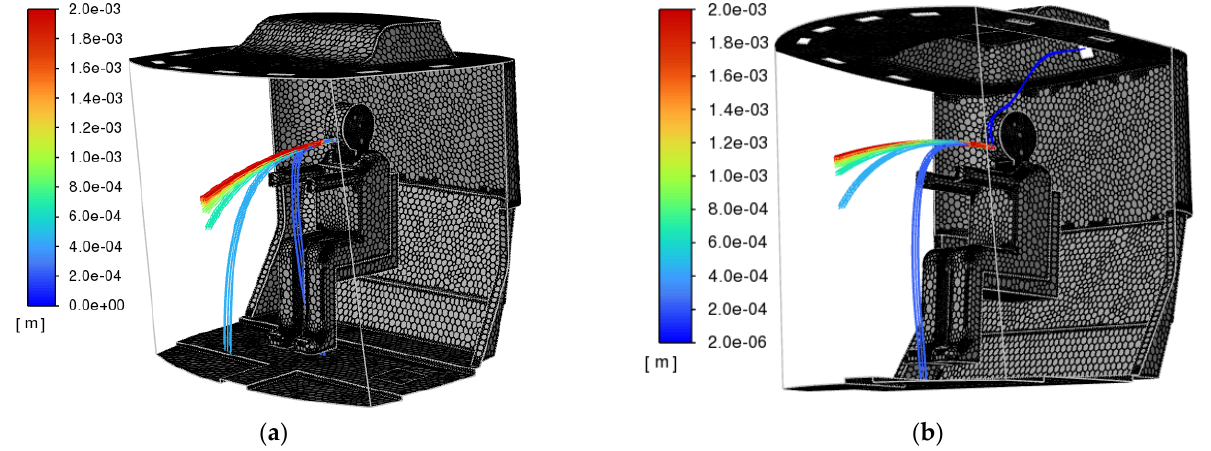
Figure 13. Trajectories and particle diameters of pathogens during the driver’s cough, the colors on the value scale correspond to the particle diameter size ( a ) with volatility and ( b ) without volatility.